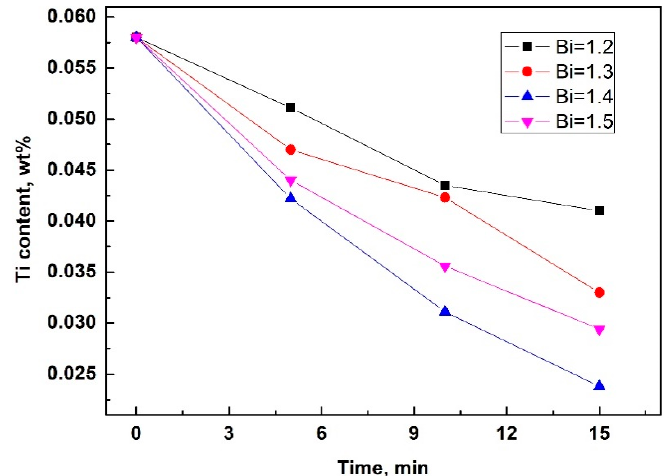
Figure 1. Ti contents of metallurgical-grade silicon during refining (using slags with different basicity indices).